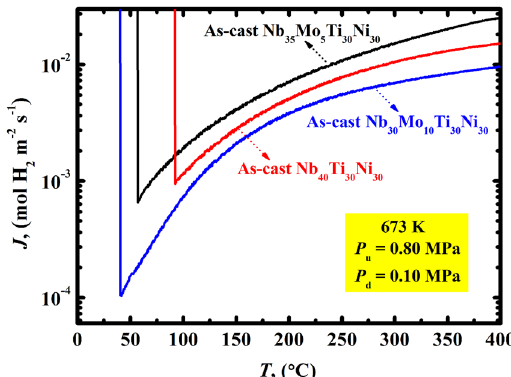
Figure 10. Measured hydrogen permeation flux during cooling from 400 °C at a cooling rate of 2 °C min − 1 for the as-cast Nb 40 Ti 30 Ni 30 , Nb 35 Mo 5 Ti 30 Ni 30 and Nb 30 Mo 10 Ti 30 Ni 30 alloy membranes. Before cooling, the alloys were placed in a hydrogen permeation atmosphere of 0.7 MPa pressure difference at 400 °C for 4